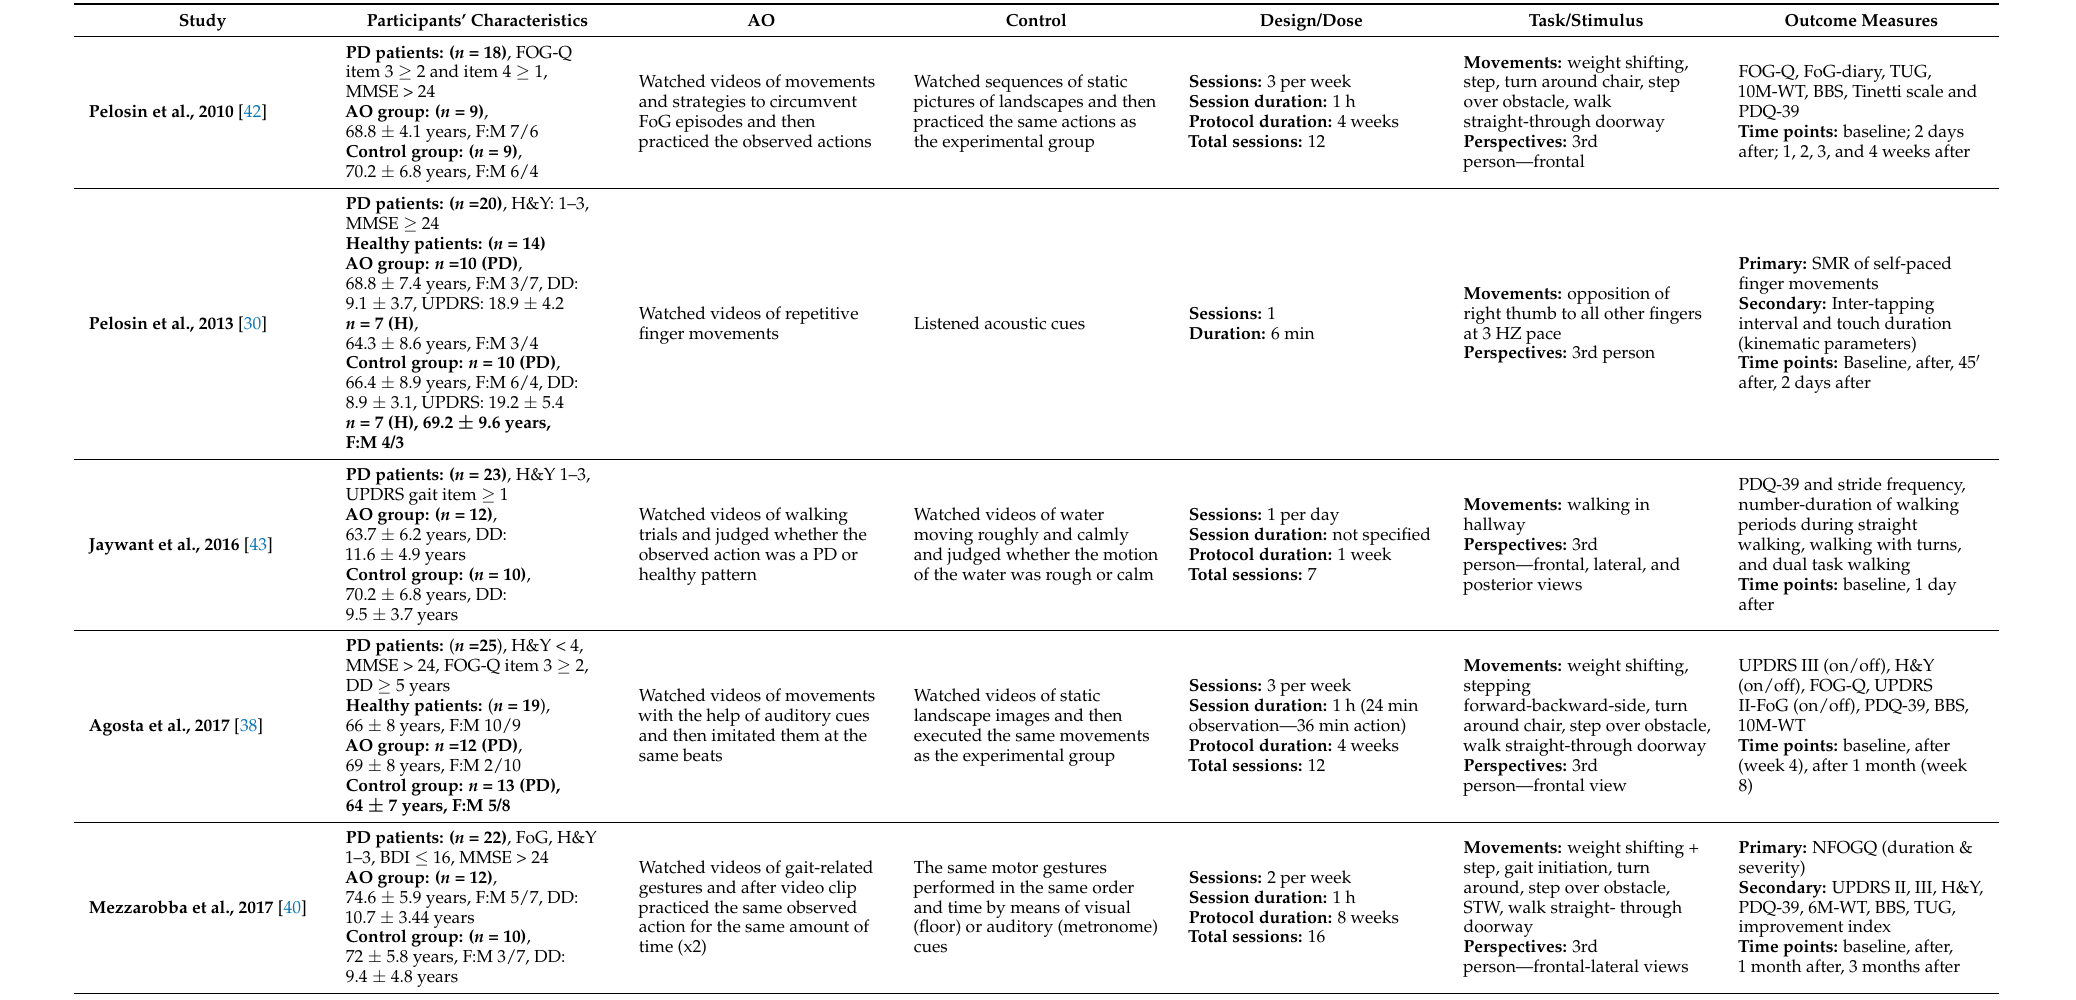
Table 1. Characteristics of the included